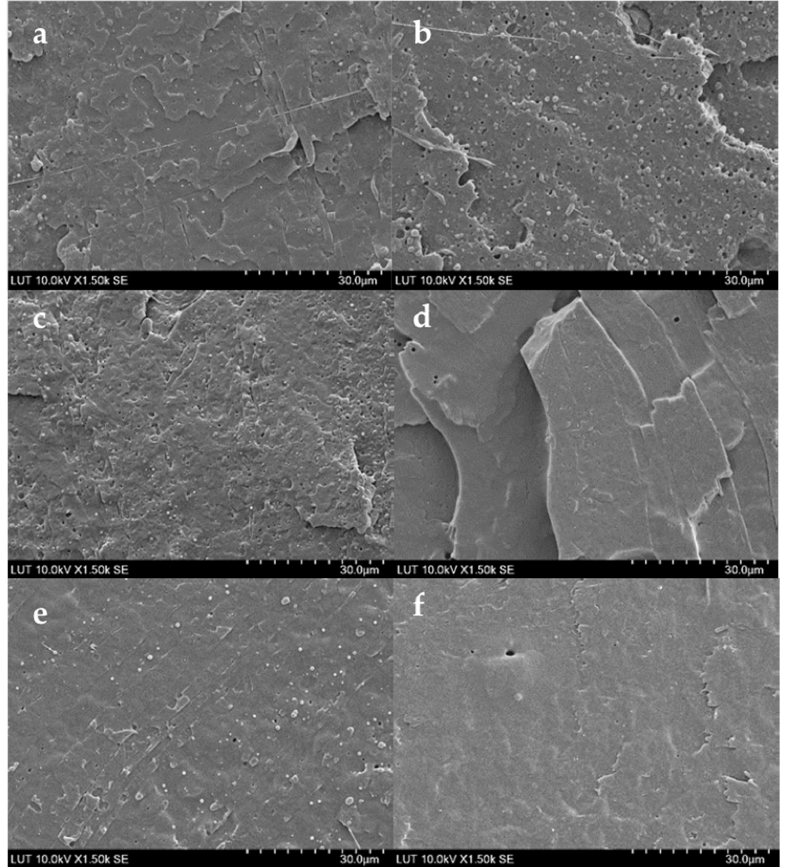
Figure 5. SEM images of ( a ) PLA80/PCL20, ( b ) PLA80/PCL20C2.5, ( c ) PLA70/PCL30, ( d ) Figure 5. SEMimagesof( a )PLA80/PCL20, ( b )PLA80/PCL20C2.5, ( c )PLA70/PCL30, ( d )PLA70/PCL30C5, PLA70/PCL30C5, ( e ) PLA60/PCL40, and ( f ) PLA 60/PCL40C5 [30]. ( e ) PLA60/PCL40, and ( f ) PLA 60/PCL40C5